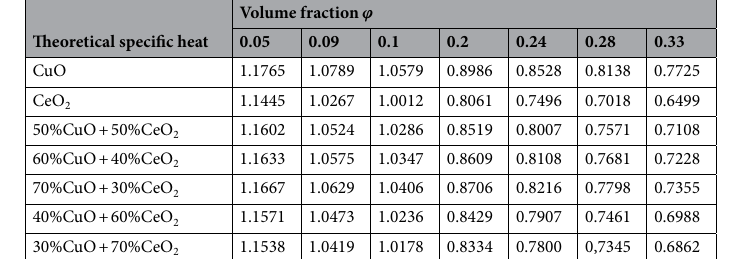
Theoretical specific